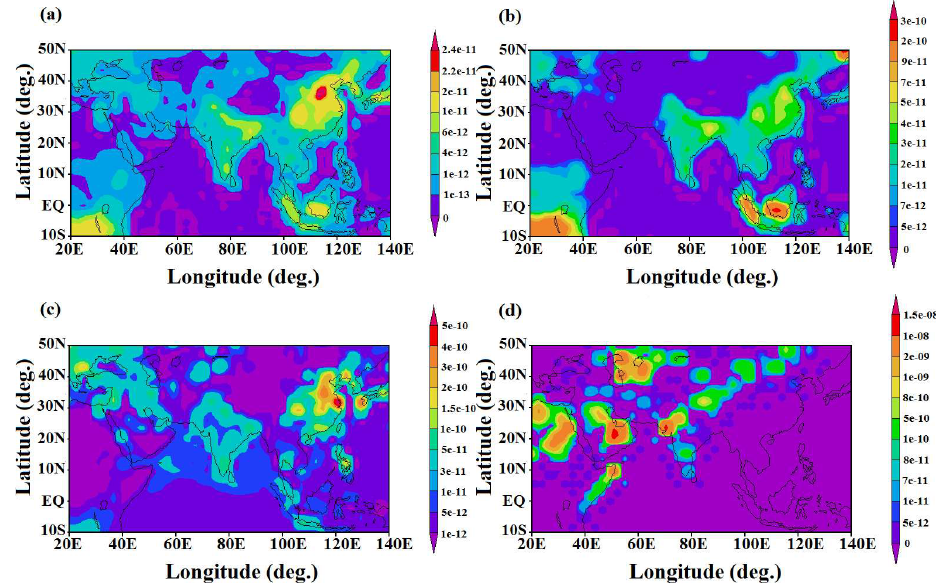
Fig. 5. Distribution of emission mass flux (kgm − 2 s − 1 ) averaged for June–September 2003 for (a) BC, (b) OC, (c) SO 2 −